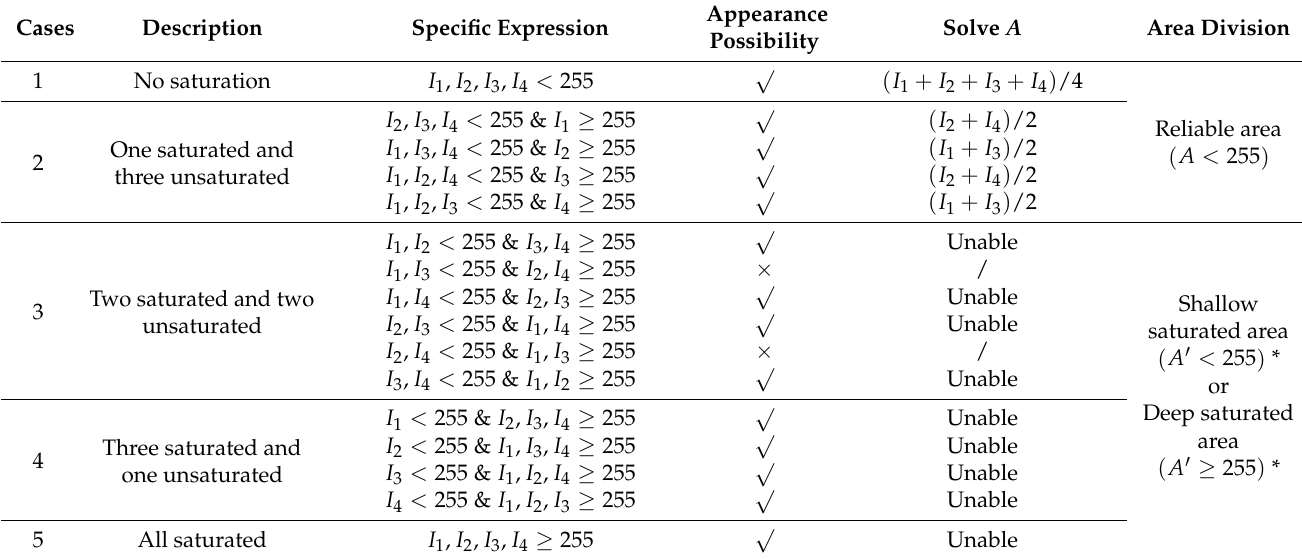
Table 1. All saturation cases in four-step